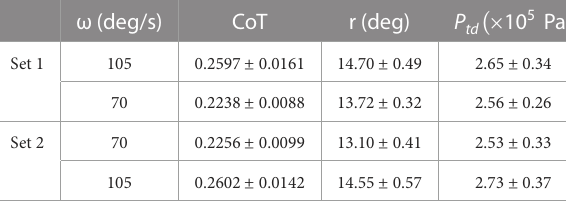
FIGURE 6 CoT of the robot trotting on uneven ground with the slope of 0 ± 0 . 5° and ground stiffness of 100 ± 10 kN/m when ω changed from 105 deg/s to 70 deg/s and vice versa abruptly after 300 blocks. The dashed and dotted lines represent the optimal values for ω = 105 deg/s and ω = 70 deg/s, respectively.